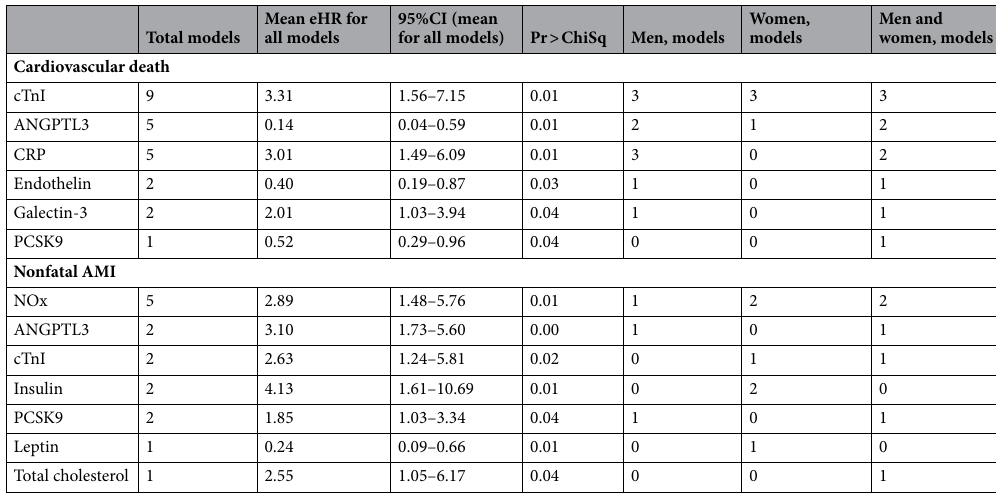
Table 3. Summary of biomarkers included in stepwise Cox regression analysis for associations with cardiovascular death and nonfatal AMI in men and women. PCSK9, proprotein convertase subtilisin/ kexin type; ANGPTL3, angiopoietin-like protein 3; NOx, nitrate and nitrite; cTnI, cardiac troponin I; CRP, C-reactive protein; eHR, estimated hazard